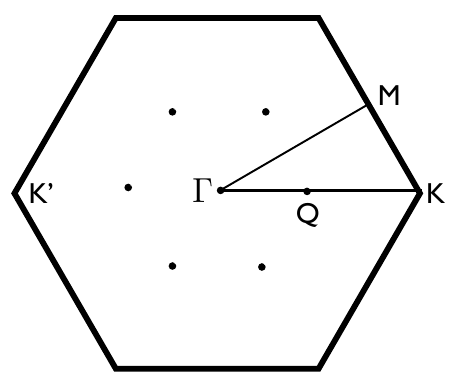
Figure 2. Two-dimensional Brillouin zone (BZ) of MX 2 . The high symmetry points Γ = ( 0,0 ) , √ K = 4 π /3 a ( 1,0 ) and M = 4 π /3 a ( 0, 3/2 ) are shown. The Q points (which are not high symmetry points) indicate the position of the edges of the conduction band in multi-layer